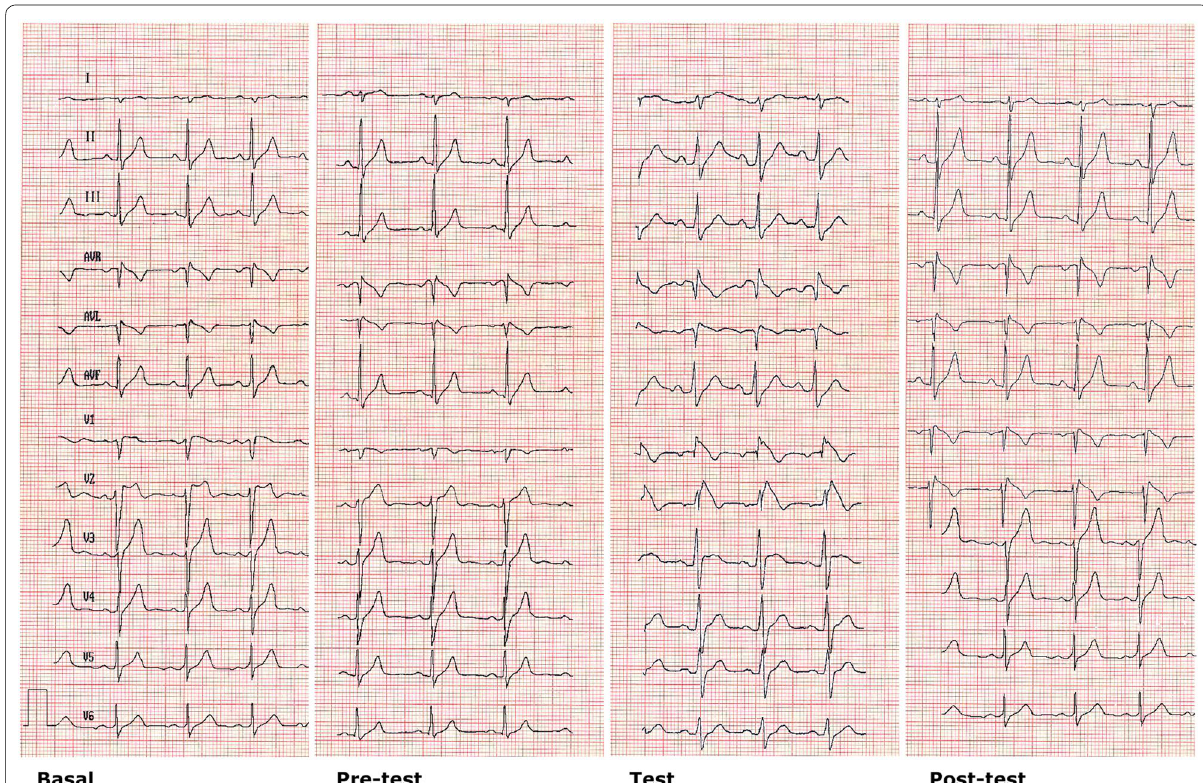
Fig. 1 Original tracing showing basal (from left, first panel), pre-test (from left, second panel), test (from left, third panel), and post-test (from left, last panel) ECG. In the basal ECG, incomplete right bundle branch block and saddle-back-like ST deviation in V1. The test ECG after flecainide clearly shows a typical pattern of Brugada. Basal tracing was obtained before starting testosterone therapy; the suspect ECG was the pre-test showing the changes in ST